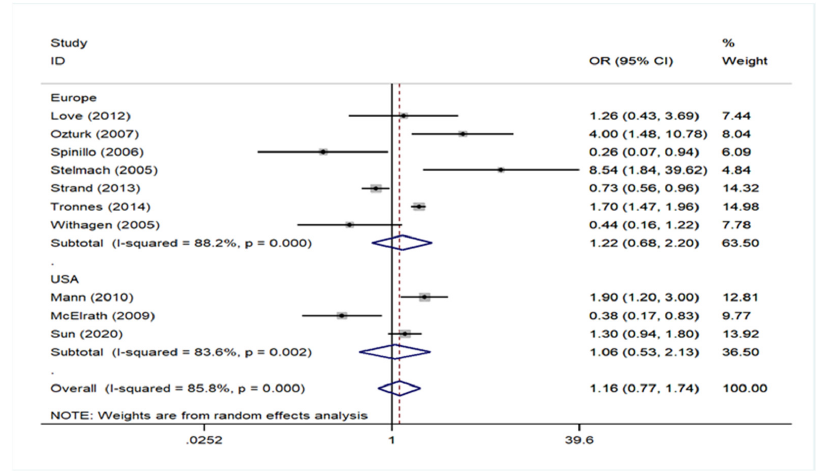
Figure 2. Forrest plot describing the association between preeclampsia and cerebral palsy based on the subgroup analysis of studies depending on geographical region.